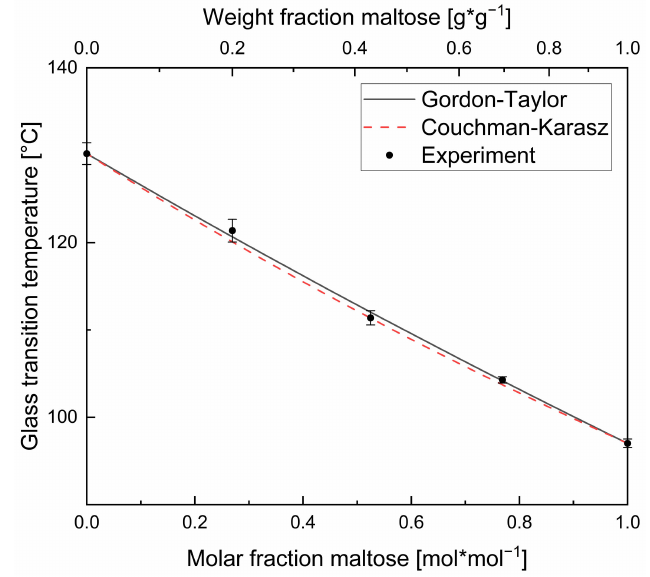
Figure 4. Experimental glass transition temperatures, Gordon–Taylor fit and Couchman–Karasz curve for the investigated, anhydrous binary maltose–maltotriose mixture.